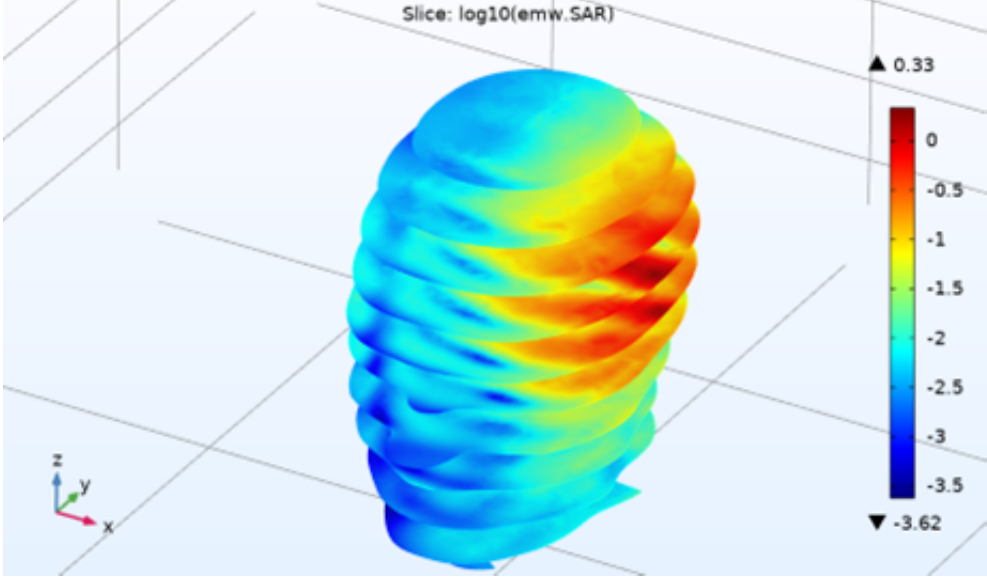
Figure 3. SAR visualization at different levels in the human